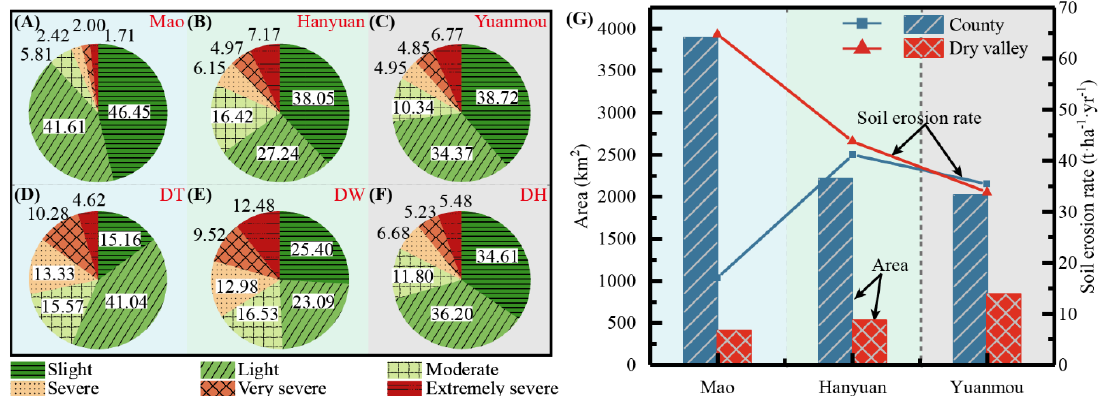
the dry valley regions were the main “source” zones of soil loss.